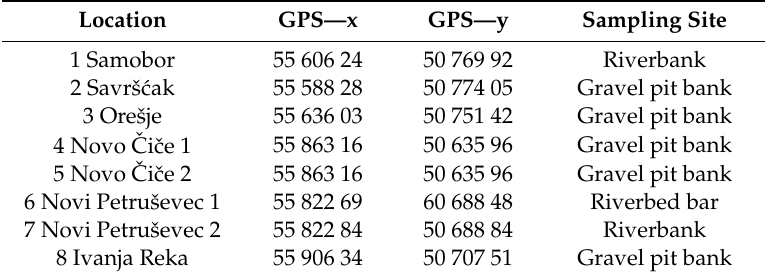
Table 1. Investigated locations, GPS coordinates, and sampling sites.